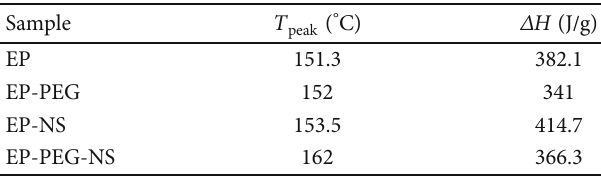
Table 7: The results of the DSC test of the samples at the heating rate of 10 °